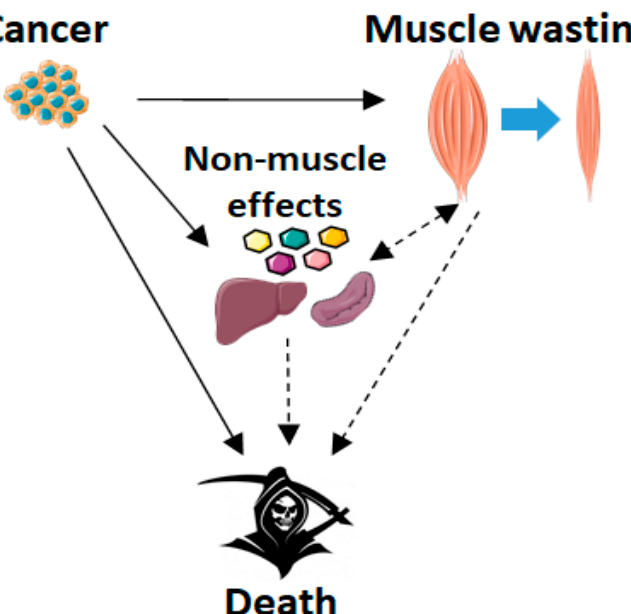
Figure 1. Hypothesis of causality between cancer cachexia and death. Dashed lines indicate inferred mechanisms requiring further investigation. Images were adapted from https://smart.servier.com (accessed on 23 February 2021).